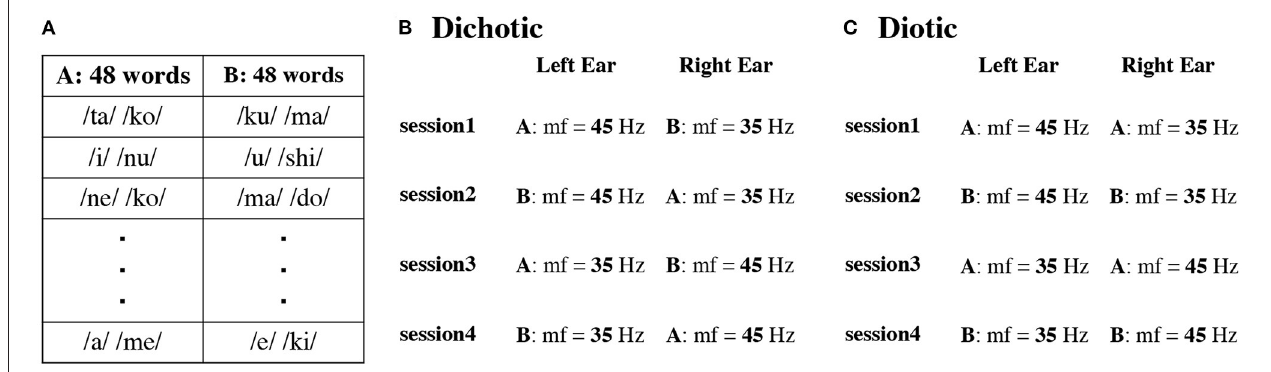
FIGURE 1 | Example of two sets (Set A and B) with different presentation order of 48 words in each participant (A) . Presentation procedure in the dichotic (B) and diotic (C) listening tasks. mf indicates modulation frequency.